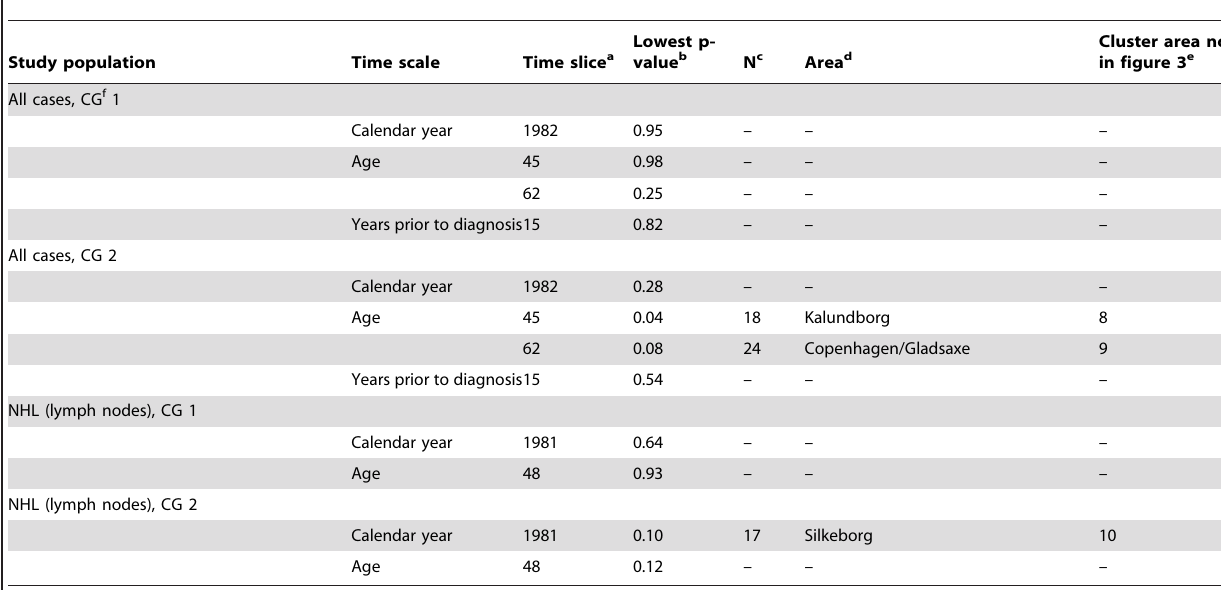
Table 3. Results of analyses performed in SaTScan at selected time slices that match the time periods with the most significant space-time clusters found by